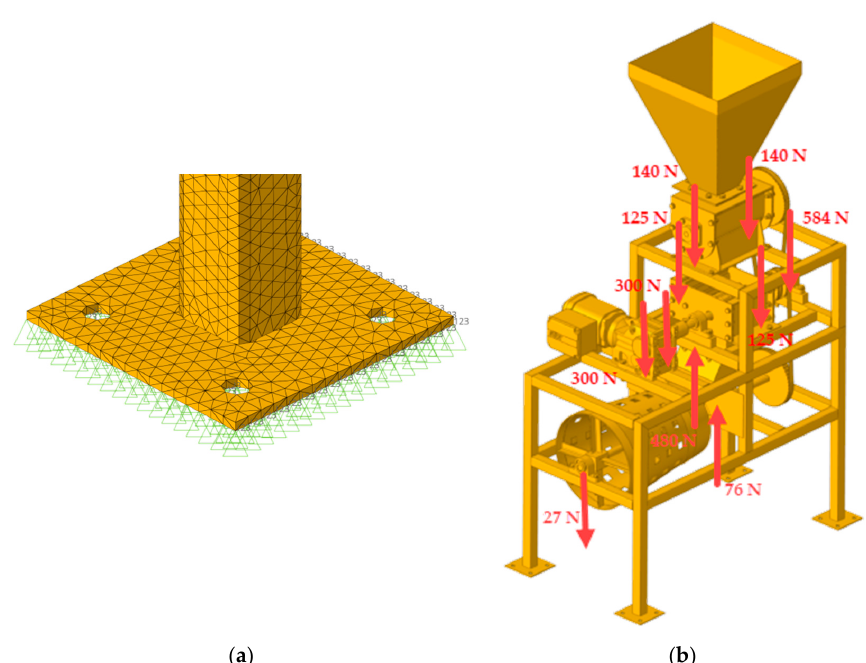
Figure 17. ( a ) Boundary conditions applied to each support; ( b ) loads applied to the structure.